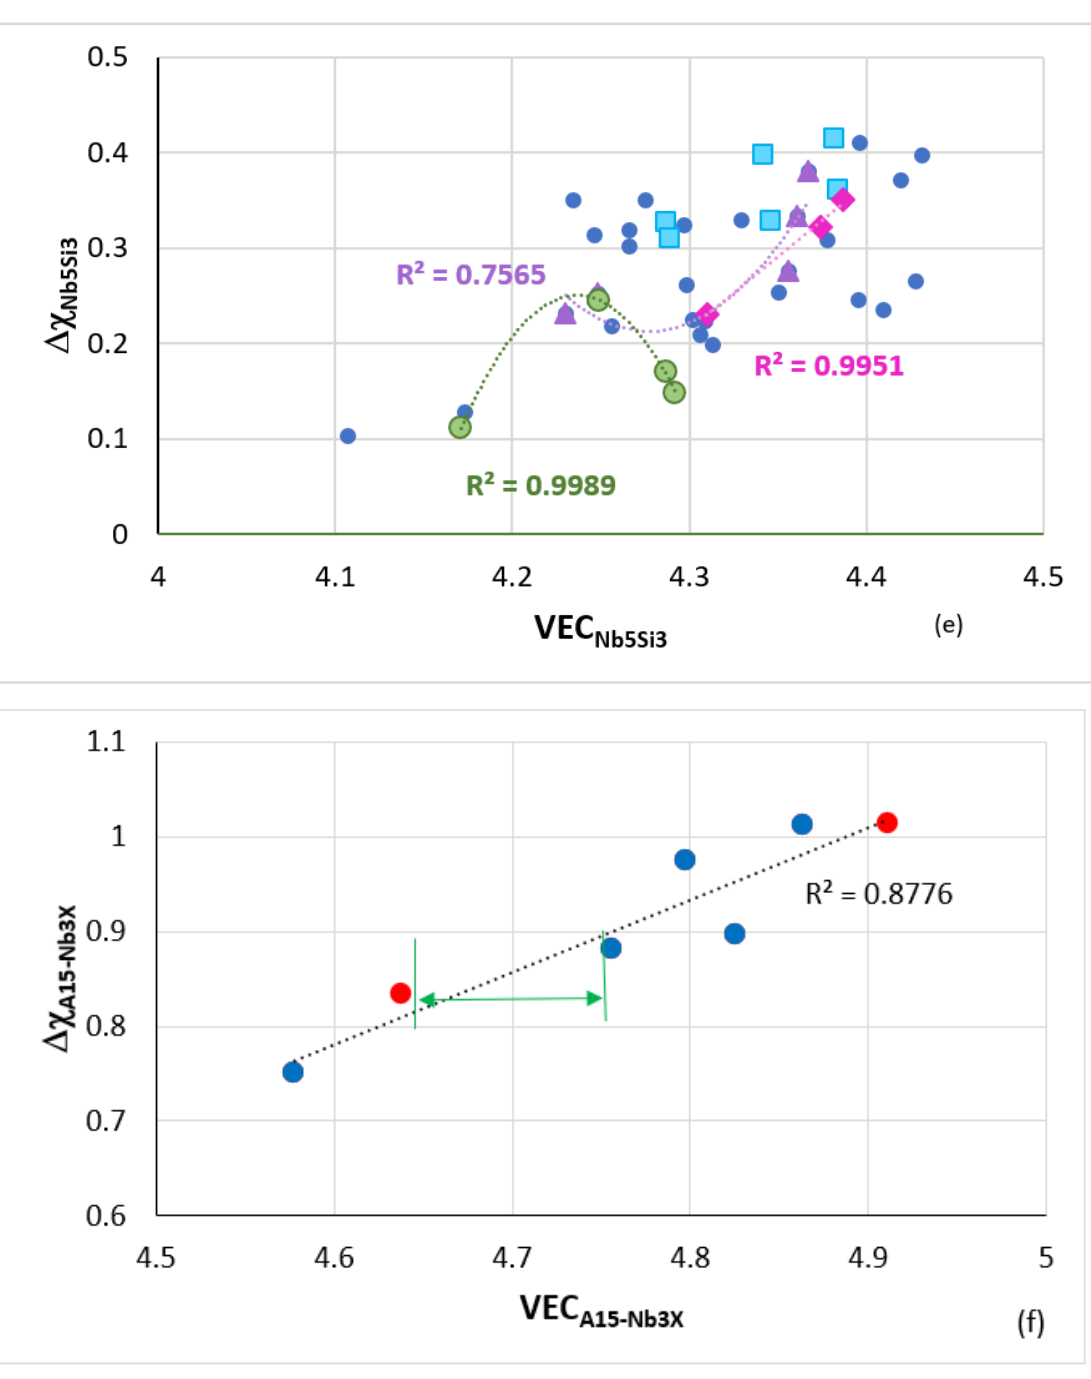
Figure 3. ( a ) ∆ χ versus VEC map of phases in RM(Nb)ICs, RM(Nb)ICs/RCCAs, and single-phase RCCAs. The single-phase RCCAs contain Nb but not Si. The data is for bcc Nb ss [8], Nb 5 Si 3 [9], C14-NbCr 2 Laves [14], eutectics of bcc Nb ss + β Nb 5 Si 3 [15], A15-Nb 3 X [14], the bcc solid solution RCCAs studied by Senkov et al. [2], the HEA bcc Nb ss , and the HEA bcc Nb ss + β Nb 5 Si 3 eutectics in RM(Nb)ICs [1,15]. The RCCAs with high VEC values are the NbMoTaW and NbMoTaWV alloys [2], the RCCAs with lower VEC values have Al, Nb and Ti additions with/without Hf [2]. ( b – e ) ∆ χ versus VEC maps of alloyed tetragonal Nb 5 Si 3 in RM(Nb)ICs and RM(Nb)ICs/RCCAs. ( b ) shows high-entropy silicides (blue circles) and complex concentrated silicides (red circles). In ( c ), the B-alloyed T2-Nb 5 (Si,B) 3 silicides are shown with green circles. In ( d ) the Ti-rich Nb 5 Si 3 is shown with brown squares and the Hf-rich Nb 5 Si 3 with red circles (note that the Nb 5 Si 3 can be Ti-rich or Hf-rich or Ti and Hf-rich (e.g., see [9,19 – 21,25,26]), the latter is the case when the metallic UHTM contains both elements). In ( b – d ) the dashed lines are drawn to help the eye see the trend in the data. In ( e ),